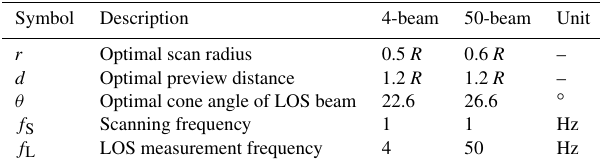
Table 2. The optimal lidar scan parameters for maximizing co- herence bandwidth. Optimal scan radii r and preview distances d are expressed in non-dimensional units normalized by the rotor ra- dius R . The parameters are chosen according to work by Simley et al. (2018). The frequencies f S and f L are based on commercial